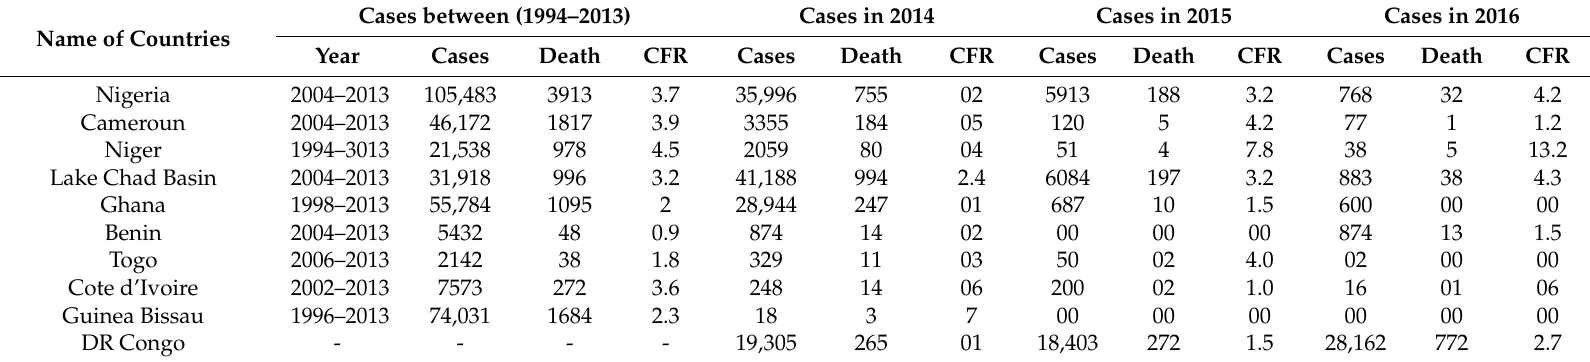
Table 4. Epidemiological updates of cholera outbreaks from 10 selected countries in Sub-Saharan Countries between 1994 and 2016. Adapted from